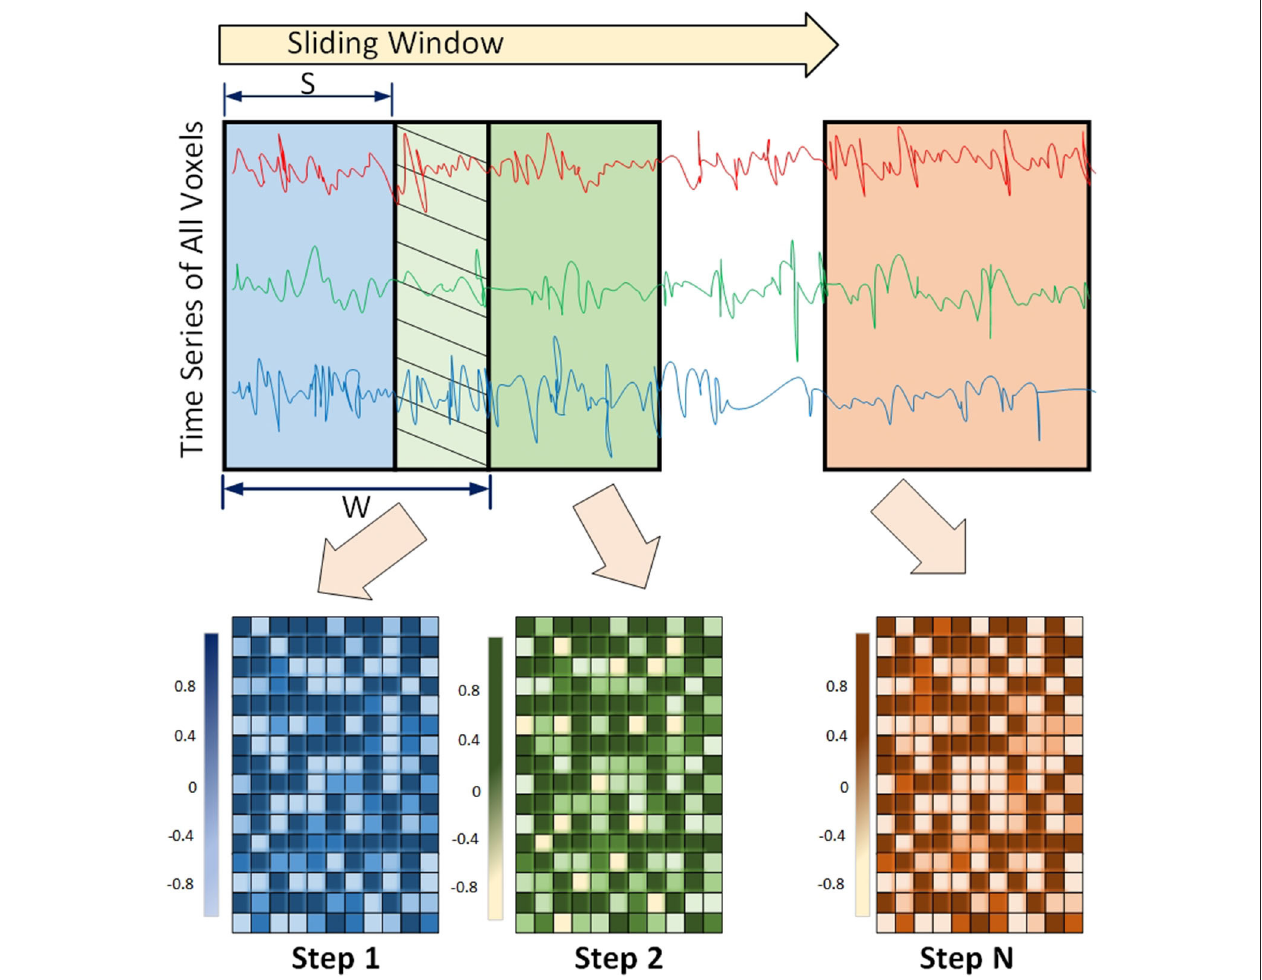
FIGURE 3 | Sliding window Framework for computing Dynamic functional connectivity (DFC) is shown. DFC is an expansion of traditional functional connectivity and assumes that functional connectivity changes over a short time - leading to more richer analysis of fMRI data using machine-learning